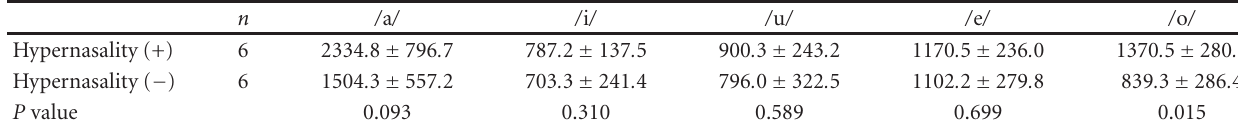
Table 2: Lyapunov exponents (mLE 1